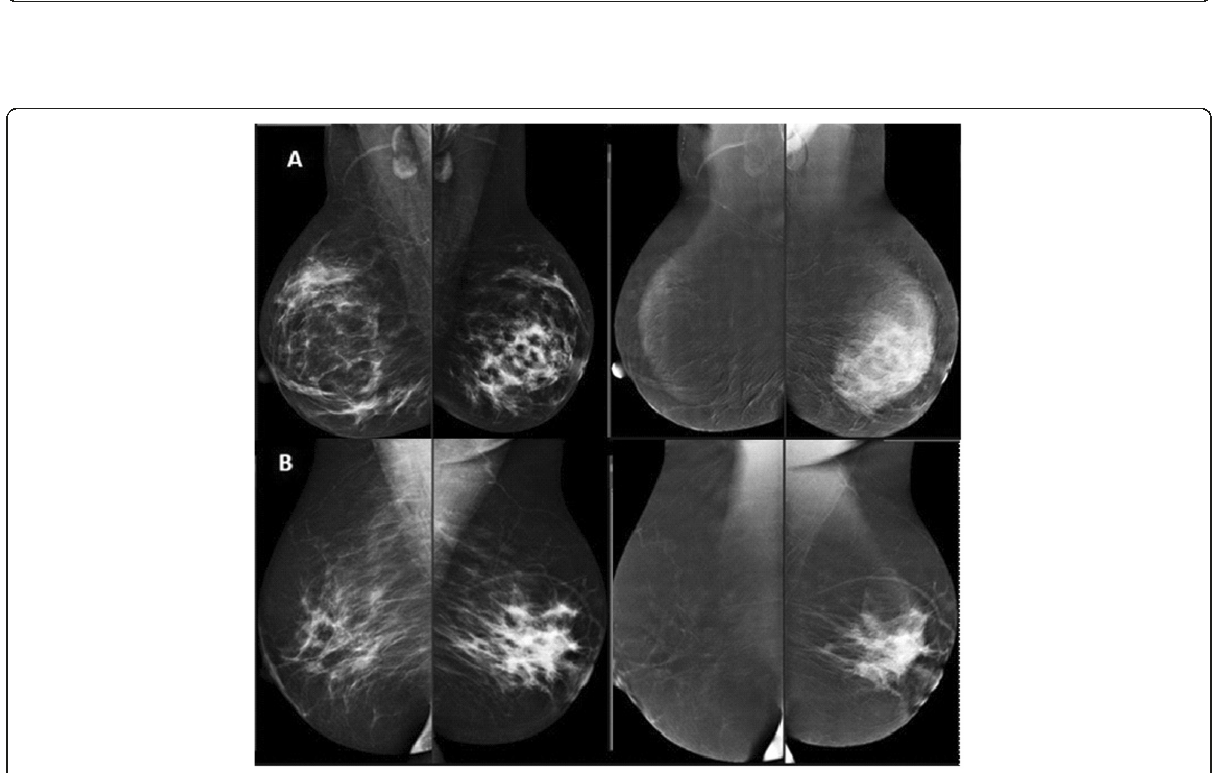
Fig. 5 Two different false-positive inflammatory lesions on both the low- and subtracted high-energy images. Biopsy revealed granulomatous mastitis ( a ) and periductal mastitis ( b